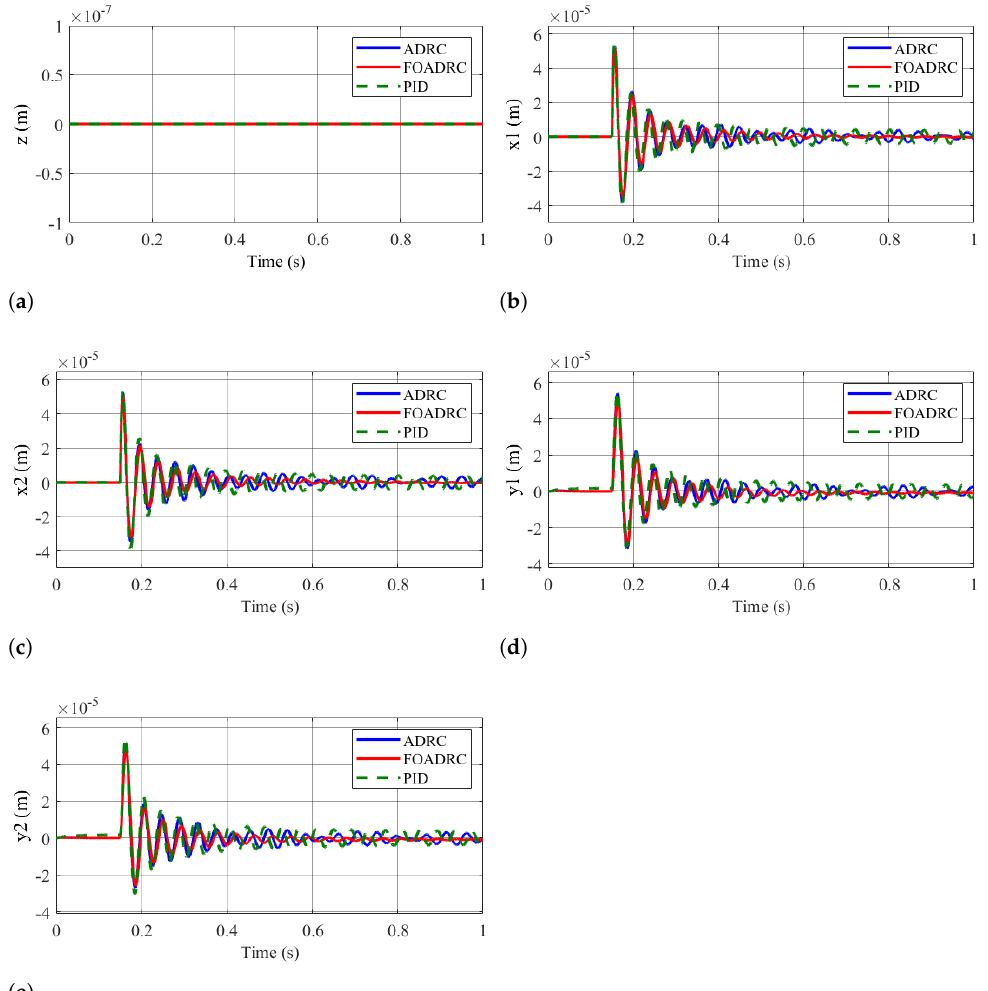
Figure 9. Transient response of rotor when a hydrodynamics force is applied in the axial and radial directions with FOADRC, ADRC, and PID controllers ( a – e